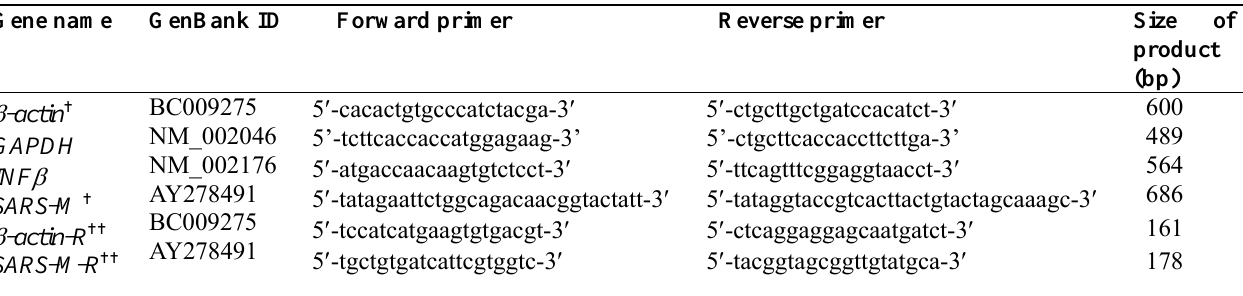
Table 1. Primers used in RT-PCR